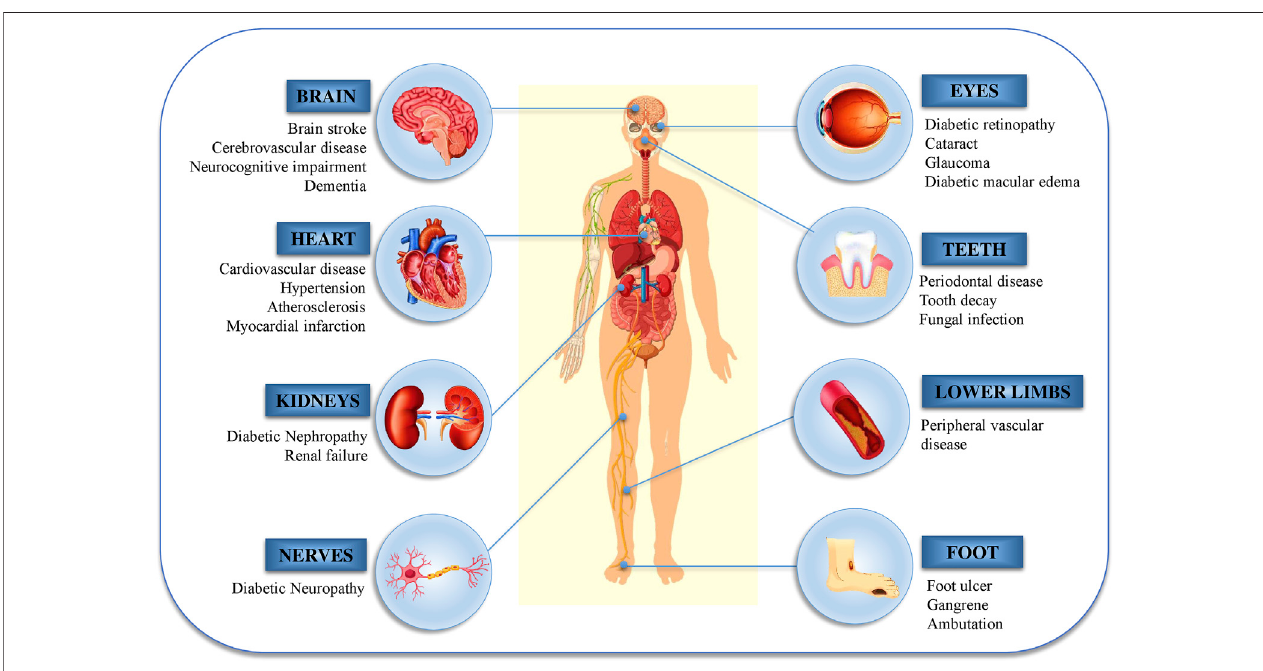
FIGURE 2 | Diabetic nephropathy, retinopathy, and neuropathy are the most common micro- and macro-vascular consequences of diabetes.